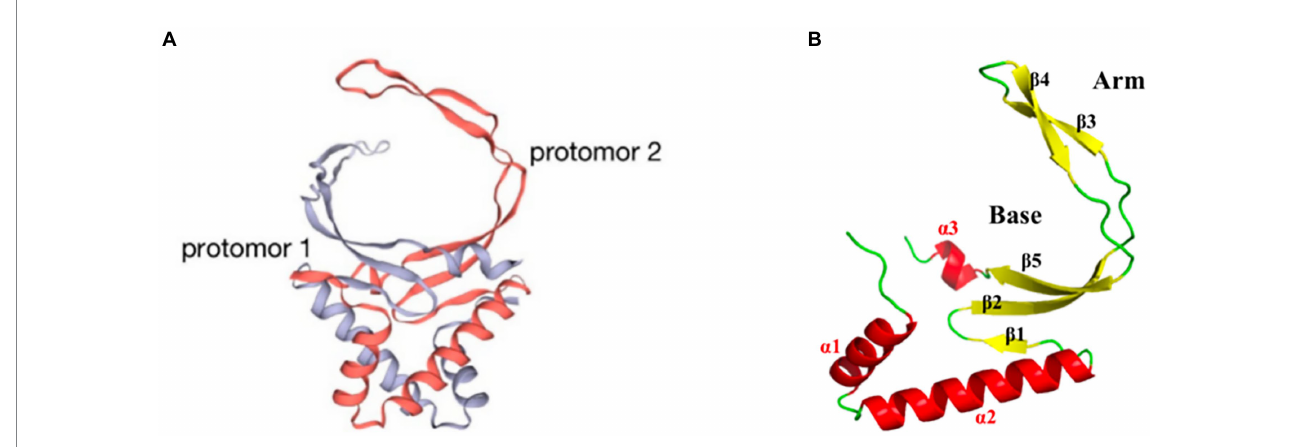
FIGURE 3 Schematic diagram of the ASFV pA104R structure. (A) The dimer structure of the pA104R protein. Gray: protomer 1; light red: protomer 2. (B) Distribution of α -helices and β -sheets in the pA104R